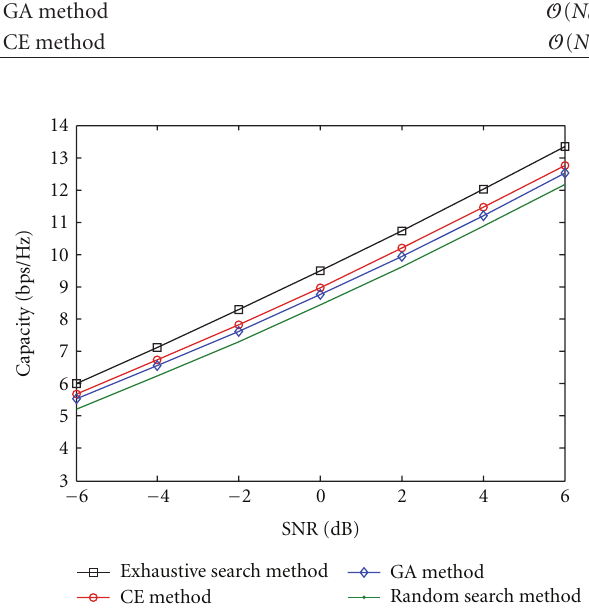
Figure 3: Capacity versus SNR for di ff erent methods.